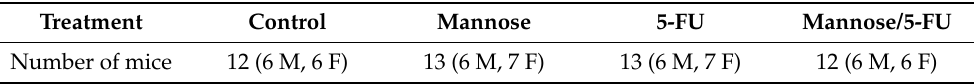
Table 1. In vivo experimental groups distribution. F: Females; M: males.